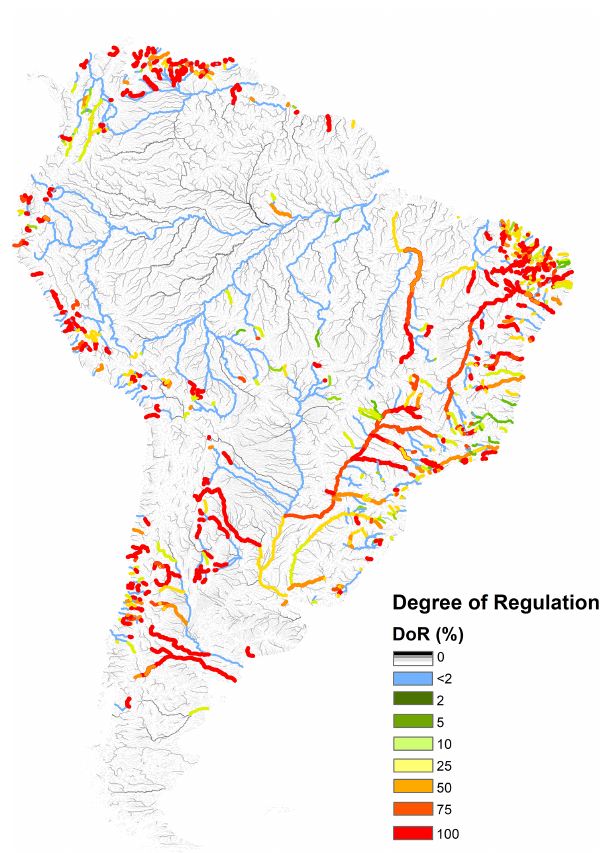
Figure 5. Degree of regulation (DoR) of reservoirs of the DDSA database in downstream rivers of South America.